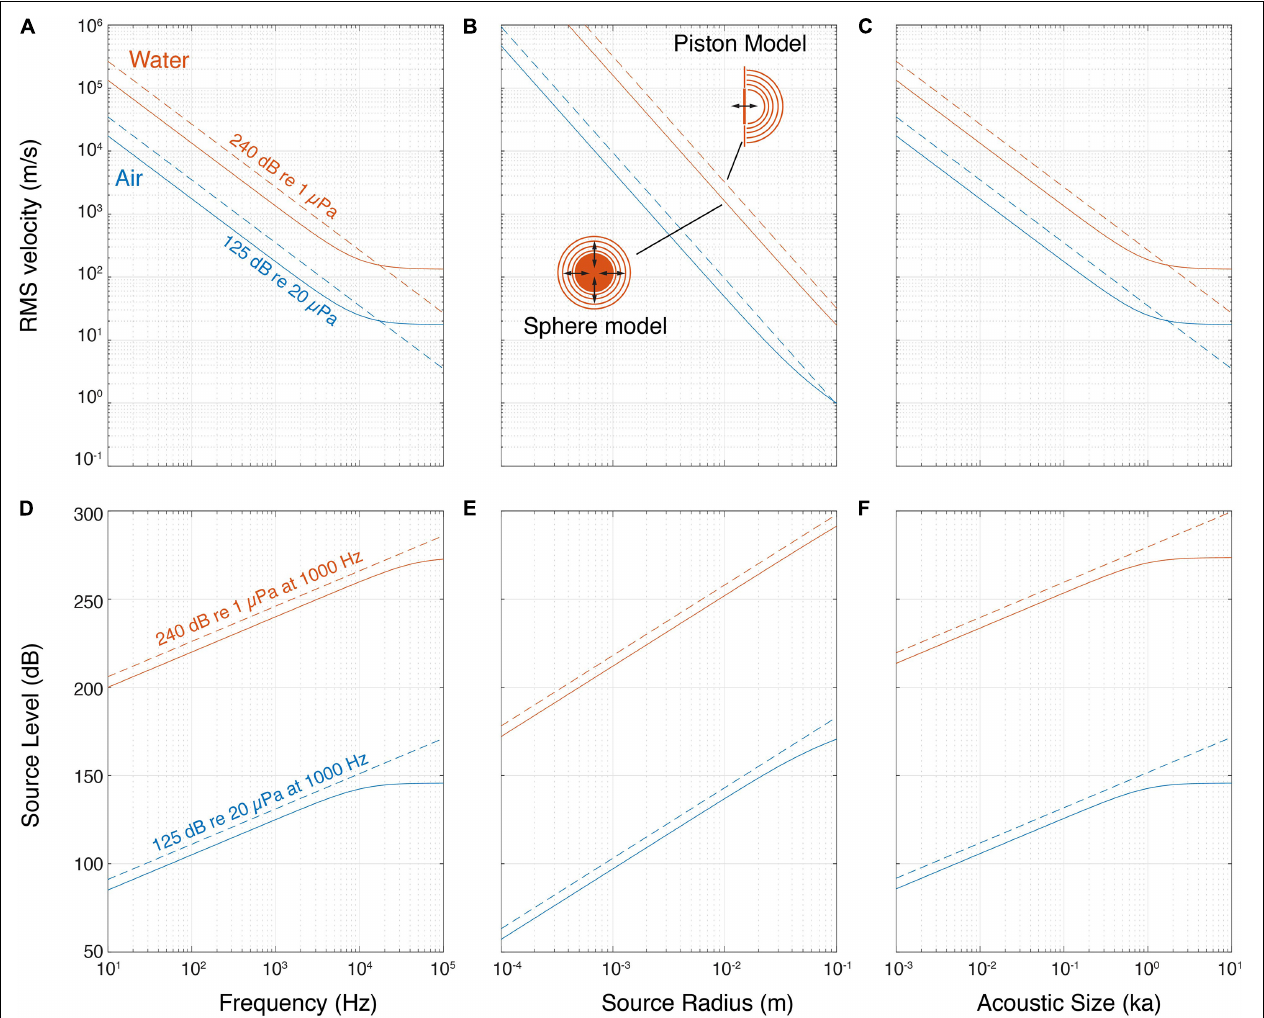
FIGURE 2 | Pulsating sphere and piston models predict that source level depends on frequency and size. (A) Isolines of a 240 dB re. 1 µ Pa and 125 dB re. 20 µ Pa source show that producing sound requires less movement with higher frequency, (B) size and (C) ka product. (D) SL increases with frequency, (E) size and (F) ka product for both sphere and piston models. The lines shown here are at a volume velocity that makes the source of 10 mm diameter produce 240 dB re. 1 µ Pa and 125 dB re. 20 µ Pa at 1,000 Hz, in water and air, respectively (see section “Materials and